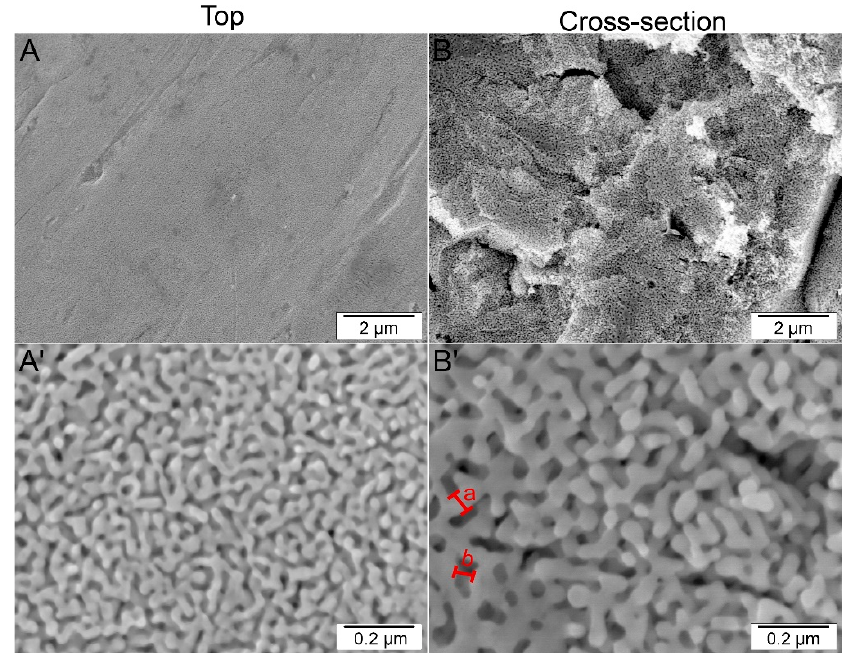
Figure 2. SEM images of top view ( A , A’ ) and cross-sectional view ( B , B’ ) of np-Au millirod at low ( A , B ) and high ( A’ , B’ ) magnifications. Letters a and b in figure ( B’ ) represent typical ligament width and interligament gaps, respectively.